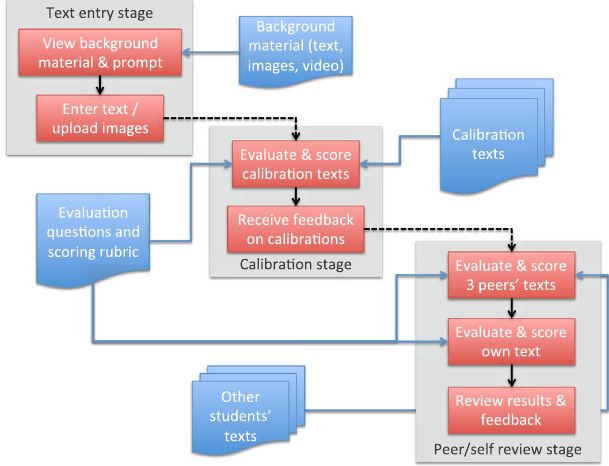
FIG. 1. Schematic of the Calibrated Peer Review process. CPR uses peer review with a training, or calibration, stage to prepare students for reviewing their peers ’ work. Students cannot proceed between stages until a deadline passes (indicated by dashed lines), but students can work within the stage at their own pace (indicated by solid lines). When appropriate, the system provides background material, calibration texts, evaluation questions, and other students ’